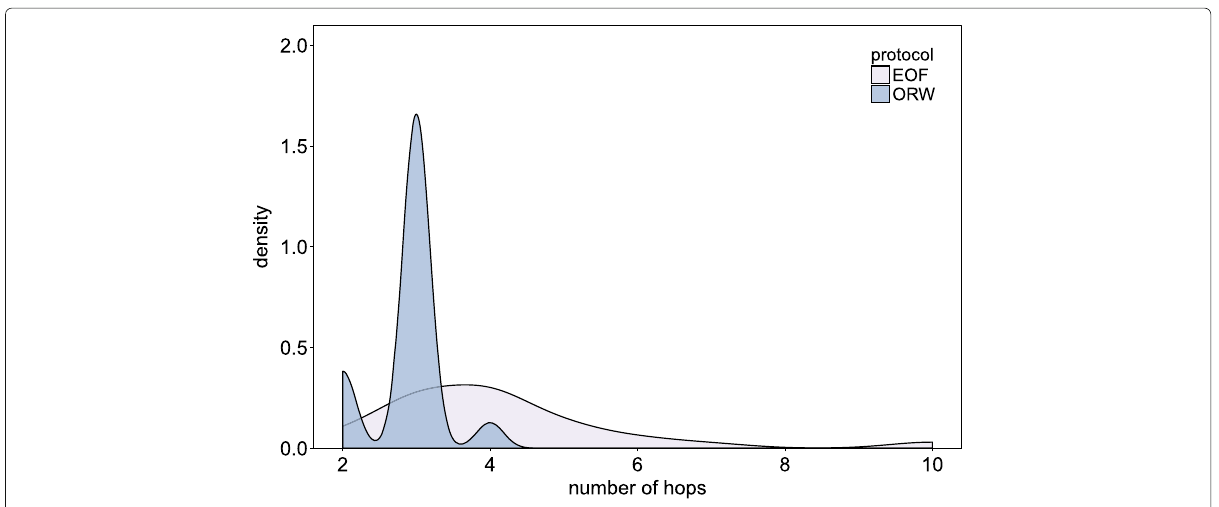
Fig. 6 Comparison of the hop count distribution of the packets received by the